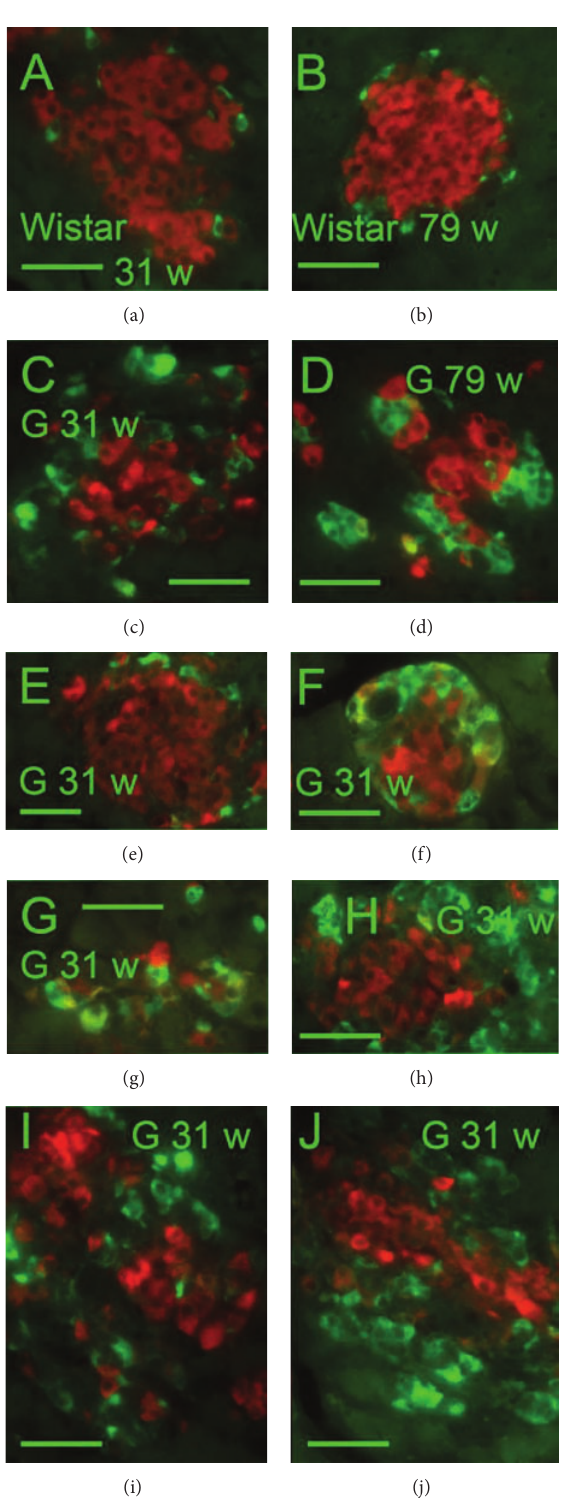
Figure 1: Insulin and somatostatin immunohistochemical pattern of pancreatic islets. Insulin: red , SST : green , and “w”: weeks. Overlay images of pancreatic islets of 31- and 79-week-old Wistar (a, b) and Goto-Kakizaki (c–j) rats “G.” Individual or a few SST-positive delta cells were observed in Wistar controls of both ages (31 and 79 weeks) (a, b). In GK rats, increased number of strongly positive delta cells containing SST was recorded predominantly in the PI periphery as well as strongly irregularly in both ages of 31 (c, e–j) and 79 weeks (d). Original magnification 400x; scale bars 50 𝜇